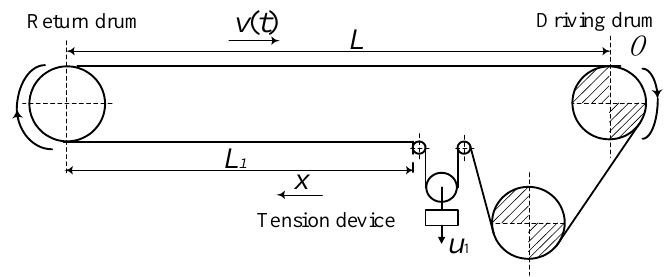
Figure 5. The transmission principle of the belt conveyor.